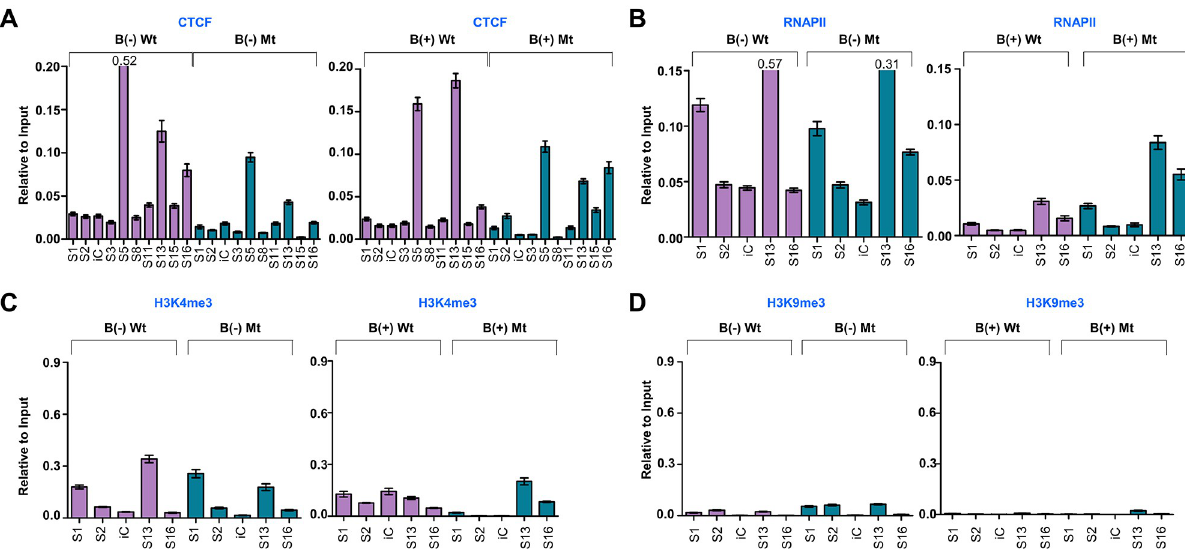
Fig 7. Analysis of epigenetic factors nearby CTCF binding sites in HEK293-EBV BART S13 cells. ChIP-qPCR assay was conducted to identify epigenetic factors nearby CTCF binding sites on EBV genome. A) CTCF ChIP-qPCR assay. Enrichment of CTCF at S1-S16 sites identified by ChIP-Seq assay was compared between BART(+/-) � S13 + HEK293-EBV cells and Mt BART(+/-) � S13 - HEK293-EBV cells. iC stands for an internal control, selected from the region (EBV 38173 ~ 38272) where CTCF did not bind to the EBV genome of SNU719 cells. B) RNAP II ChIP-qPCR assay. Enrichment of RNAP II at S1-S16 sites identified by ChIP-Seq assay was compared between BART(+/-) � S13 + and Mt BART(+/-) � S13 - HEK293-EBV cells. C) H3K4me3 histone ChIP-qPCR assay. Enrichment of H3K4me3 histone at S1-S16 sites identified by ChIP-Seq assay was compared between BART(+/-) � S13 + and Mt BART(+/-) � S13 - HEK293-EBV cells. D) H3K9me3 histone ChIP-qPCR assay. Enrichment of H3K9me3 histone at S1-S16 sites identified by ChIP-Seq assay was compared between BART(+/-) � S13 + and Mt BART(+/-) � S13 - HEK293-EBV cells. In panels, experiments were independently repeated two times, and data are represented as mean ±